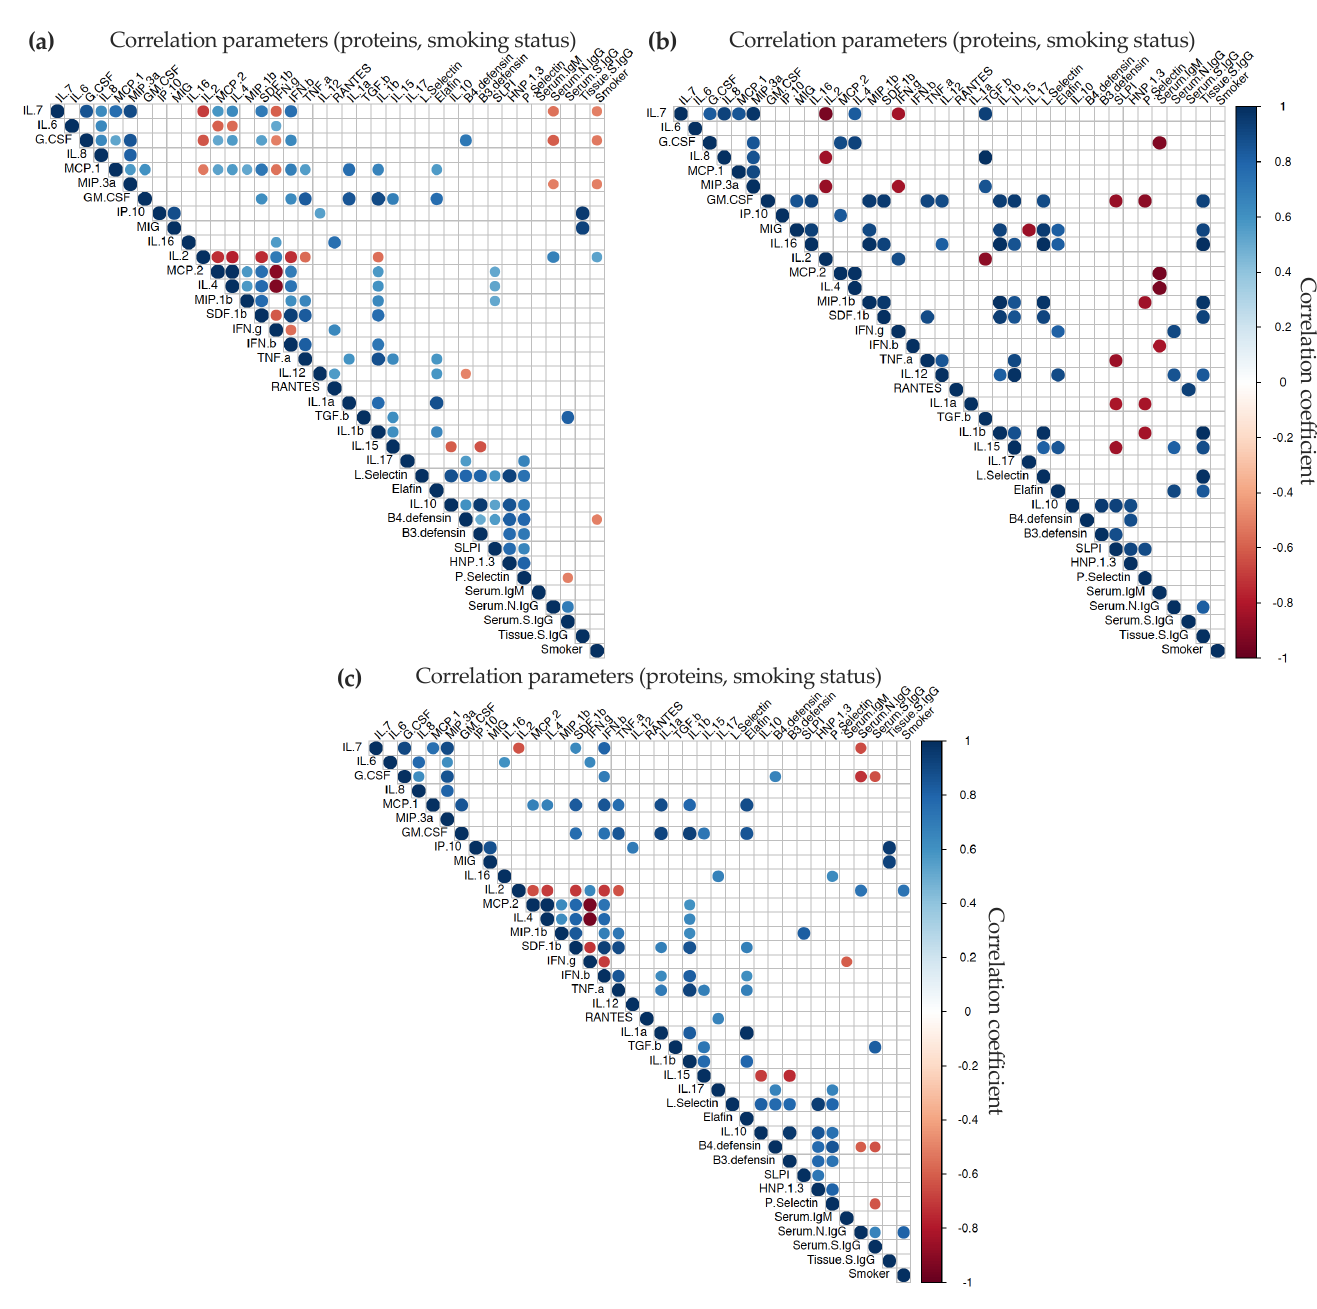
Figure 5 . Correlogram of significant responses elicited in nasal explants. Significant (p < 0.05) correlations between concentrations of nasal cytokines/chemokines, serum and tissue Ab levels and smoking-status for all participants ( a ), vaccine-naïve ( b ) or BioNTech/Pfizer-vaccinated participants ( c ) were analyzed by a correlation matrix. Positive Pearson correlations coefficients are displayed in blue and negative correlations in red color. The color intensity indicated in the side bar is proportional to the correlation coefficient. The size of the circle is proportional to the statistical significance of the correlation.